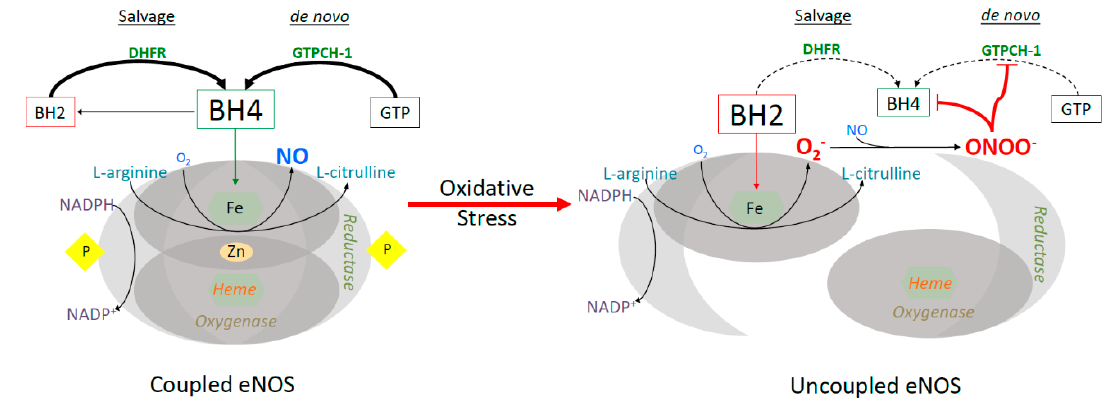
Figure 1. Endothelial nitric oxide (eNOS) uncoupling in states of oxidative stress. The functional eNOS dimer, producing nitric oxide, is seen on the left. eNOS dysfunction, on the right, occurs in states of oxidative stress, where BH4 is oxidized, eNOS is undimerized and uncoupled. In this state, nitric oxide is no longer produced and instead superoxide radical is generated. The salvage and de novo BH4 biosynthesis pathways are actively producing BH4 in normal conditions, but are impaired by oxidative stress, specifically derived from eNOS uncoupling.